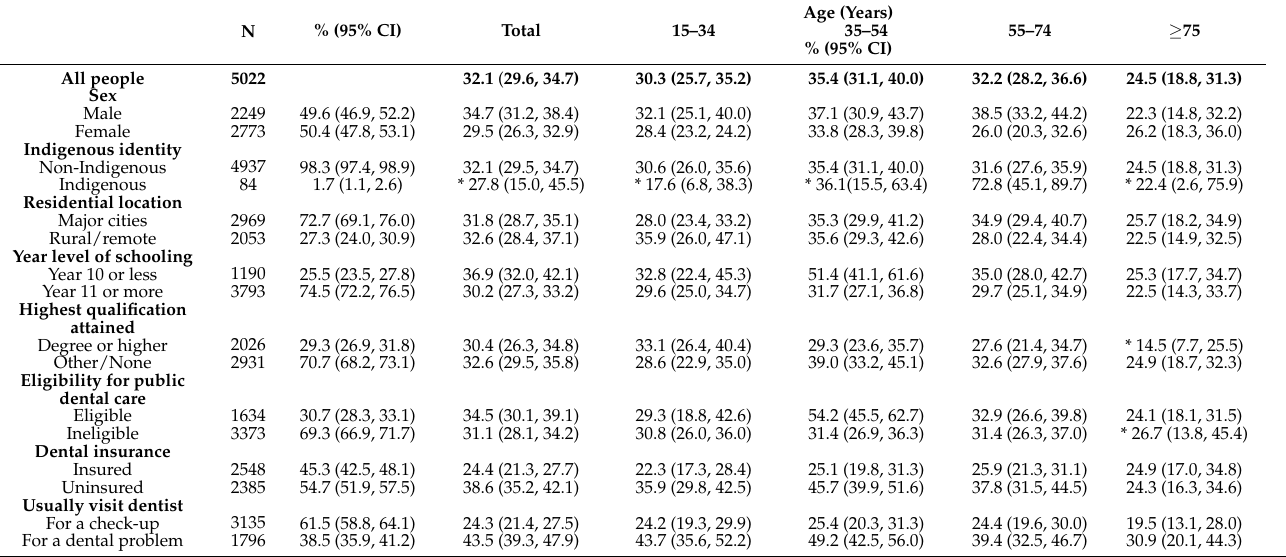
Table 1. Proportion of Australian dentate adults aged 15 years and over with untreated coronal caries.